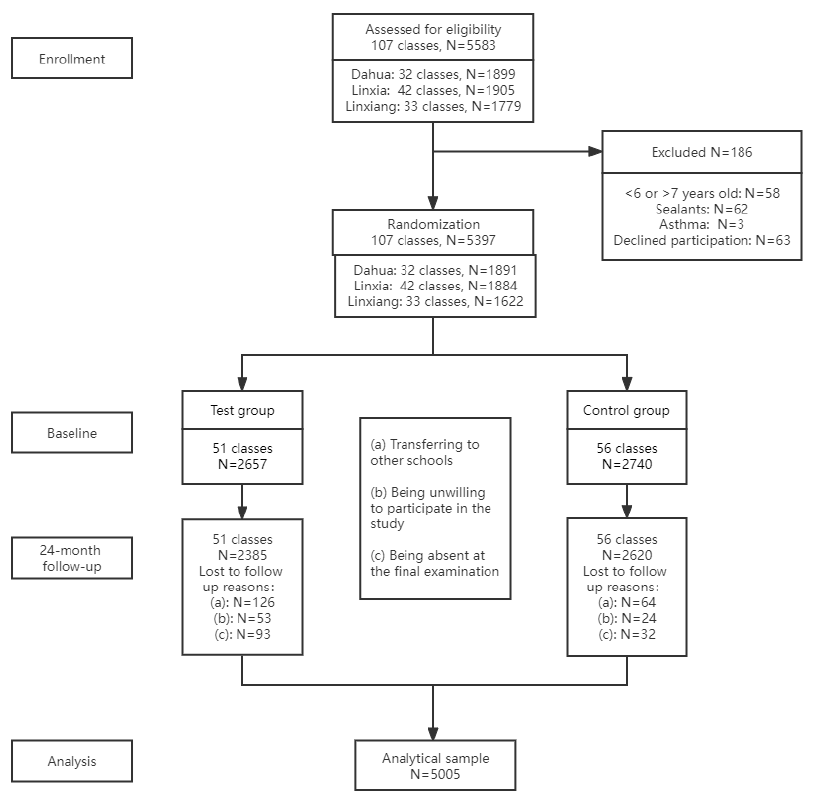
Figure 1. Flowchart of the participants of the trial.